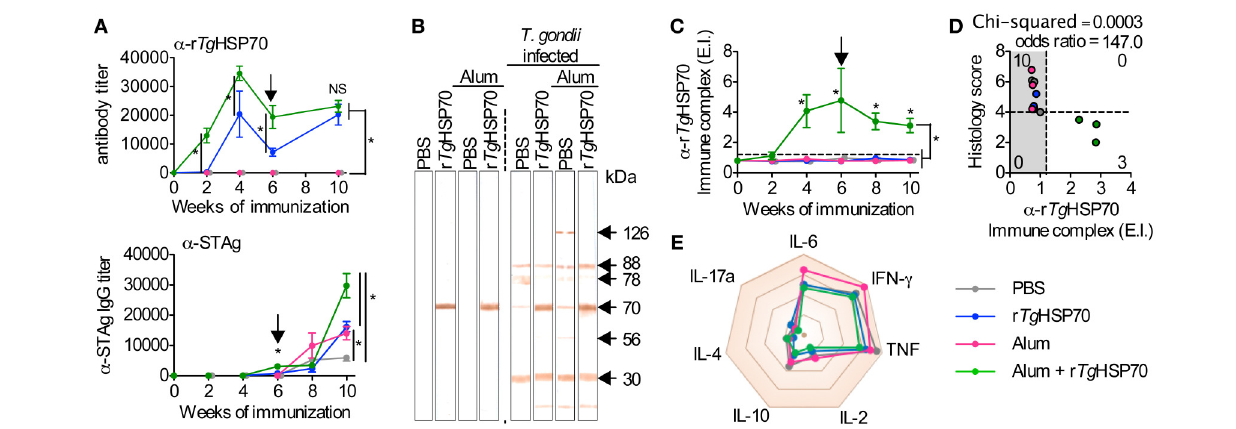
FIGURE 2 | r Tg HSP70 immunization induces strong anti- r Tg HSP70 antibody response. (A) ELISA for quantification of total anti-r Tg HSP70 and anti-STAg IgG titers from C57BL/6 mice during immunization (week 0–6) and infection period (week 6–10). Arrow indicates when mice were infected. (B) STAg proteins were separated by SDS-PAGE and transferred to PVDF membrane. Immunoblotting against-STAg was performed using sera from the each immunization group prior (week 6) and after infection (week 10). (C) ELISA for quantification of anti-r Tg HSP70 ICs in the serum. IC values above ELISA index threshold (dashed line) indicate the presence of anti-r Tg HSP70 in serum. (D) Association plot between anti-r Tg HSP70 IC and histological score (from Figure 1D ) at week 10. Dashed lines represent ELISA index threshold and histological score threshold. (E) Radar plot summarizing serum cytokine profile displayed is Sup Figure 4. E.I., ELISA index. Data are representative of two independent experiments with five mice per group. * P < 0.05, two-way ANOVA test (A,C) . Chi-squared and odds ratio test were used for association between categorical data (D) . Error bars indicate mean ± SEM.